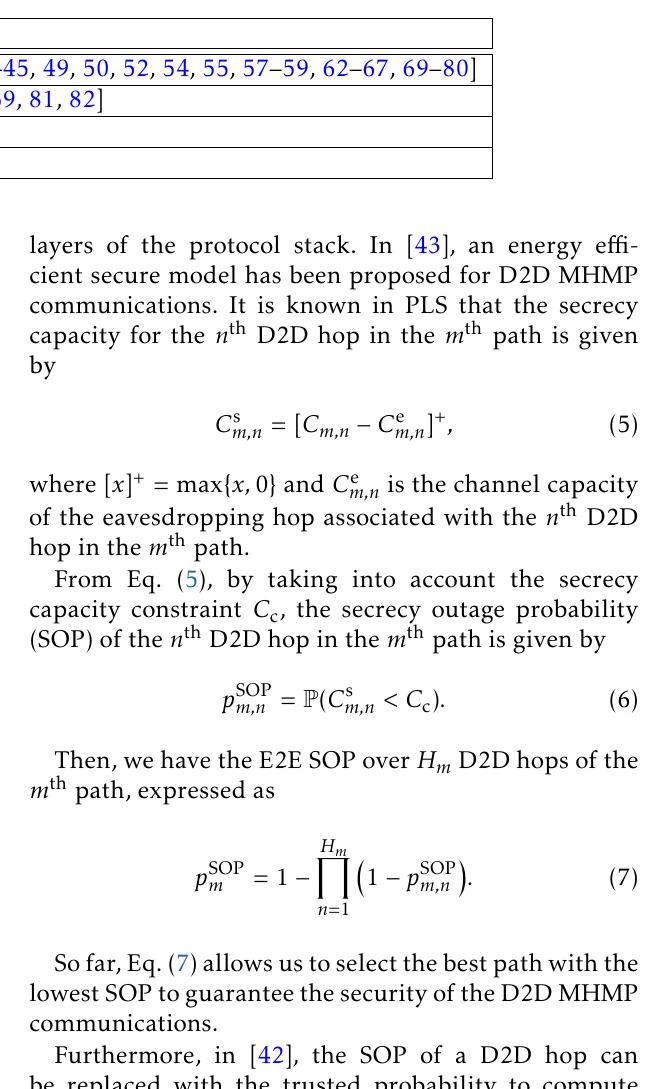
Table 2. D2D MHMP Communications Techniques